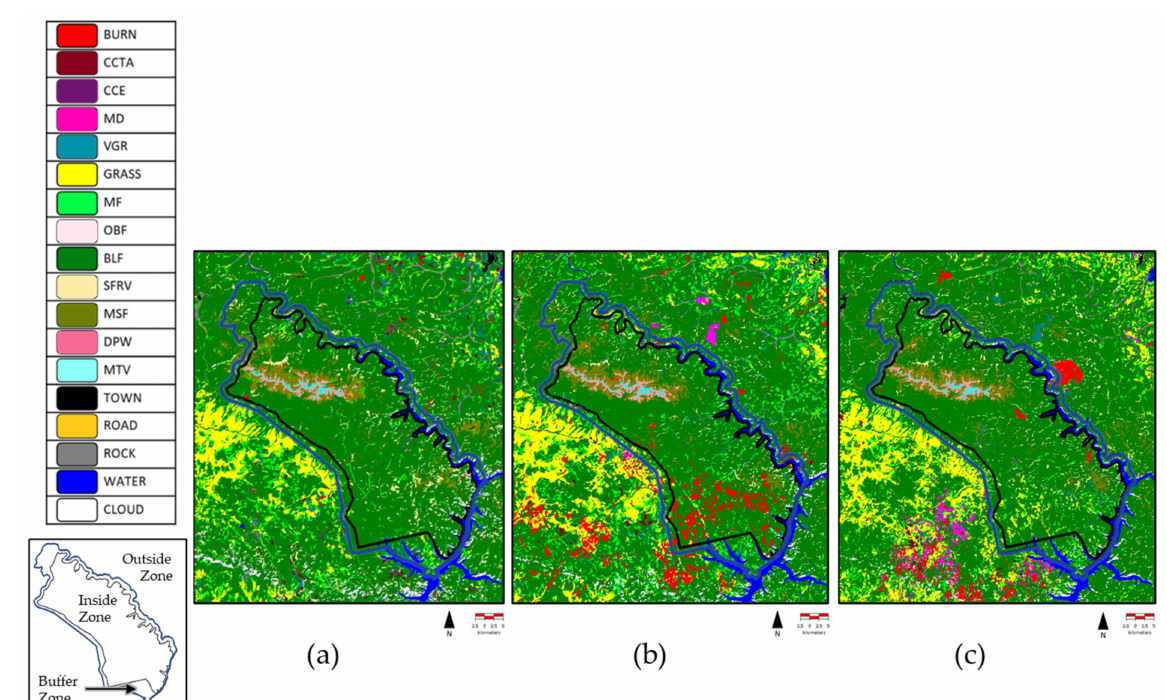
Figure 4. Change maps obtained from object-based segmentation classification to detect the change of forest cover in the Scheme 1988 ( a ). ( b ) 1999–2010, and ( c ) 2010–2016. BURN = burned area, CCTA = clearcutting for timber or agricul- tural, CCE = clearcutting for electricity lines, MD = mixed disturbance, VGR = vegetation recovery, GRASS = grassland, MF = mixed forests, OBF = oak–Daurian birch forests, BLF = birch and larch forests, SFRV = spruce forests in a river valley, MSF = mountain spruce forests, DPW = dwarf pine woodland, MTV = mountain tundra vegetation, TOWN = settlement, ROAD = unpaved road, ROCK = stream bedrocks, and WATER =